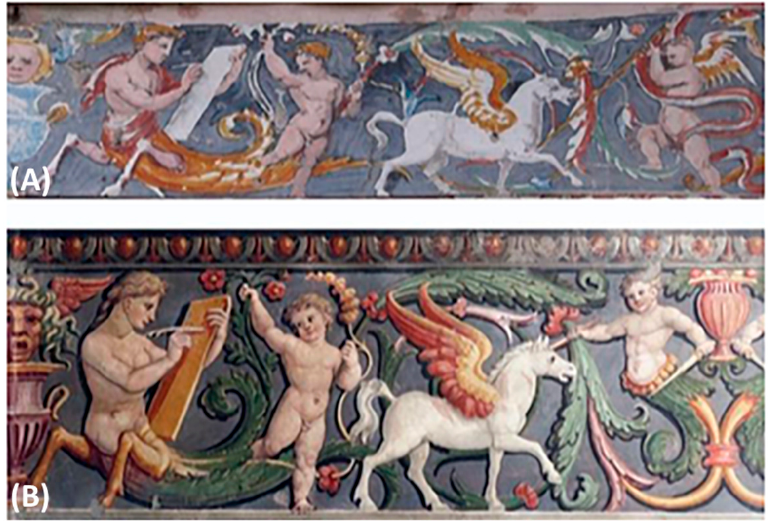
Figure 5. Frieze in the church of S. Maria della Fortezze (Viterbo) ( A ) compared with that of the Sala Riario of Palazzo Gallo ( B ).